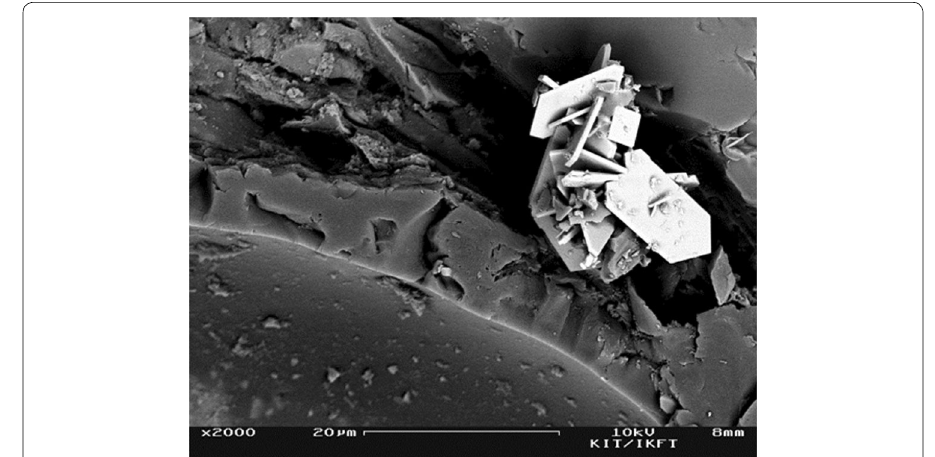
Fig. 10 Growth of euhedral, tabular barite crystals sample 12.1 (PV10; 20 °C/20 bar)